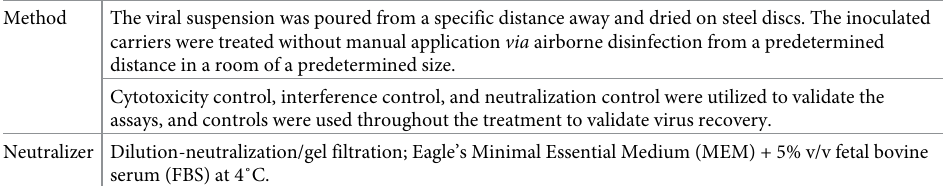
Table 1. Test method and